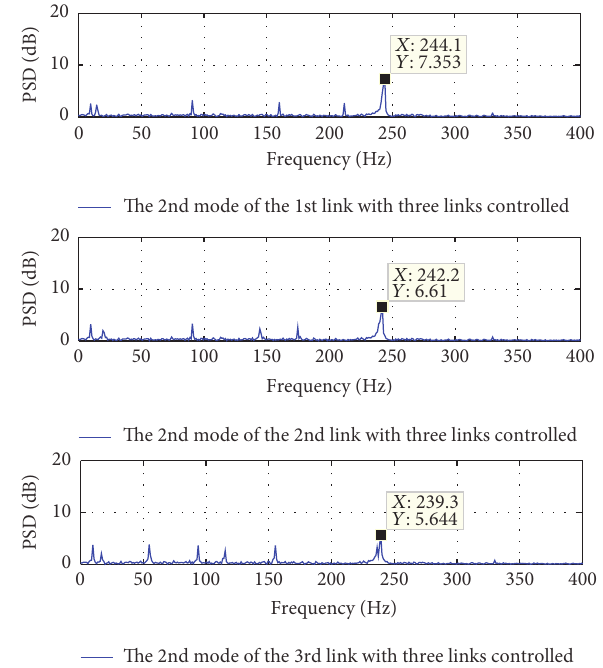
Figure 16: The PSD plot of the second mode of the three links with